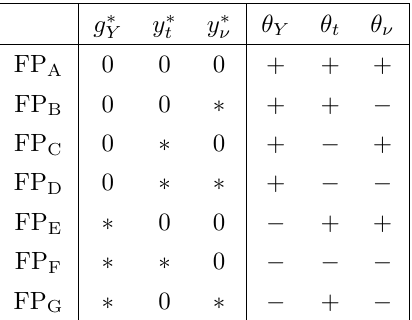
Table 2. The real fixed points of the system of eqs. (3.11)–(3.13) when f y < f crit indicates a non-zero value. In the right-hand side box the signs of the relative critical exponents are